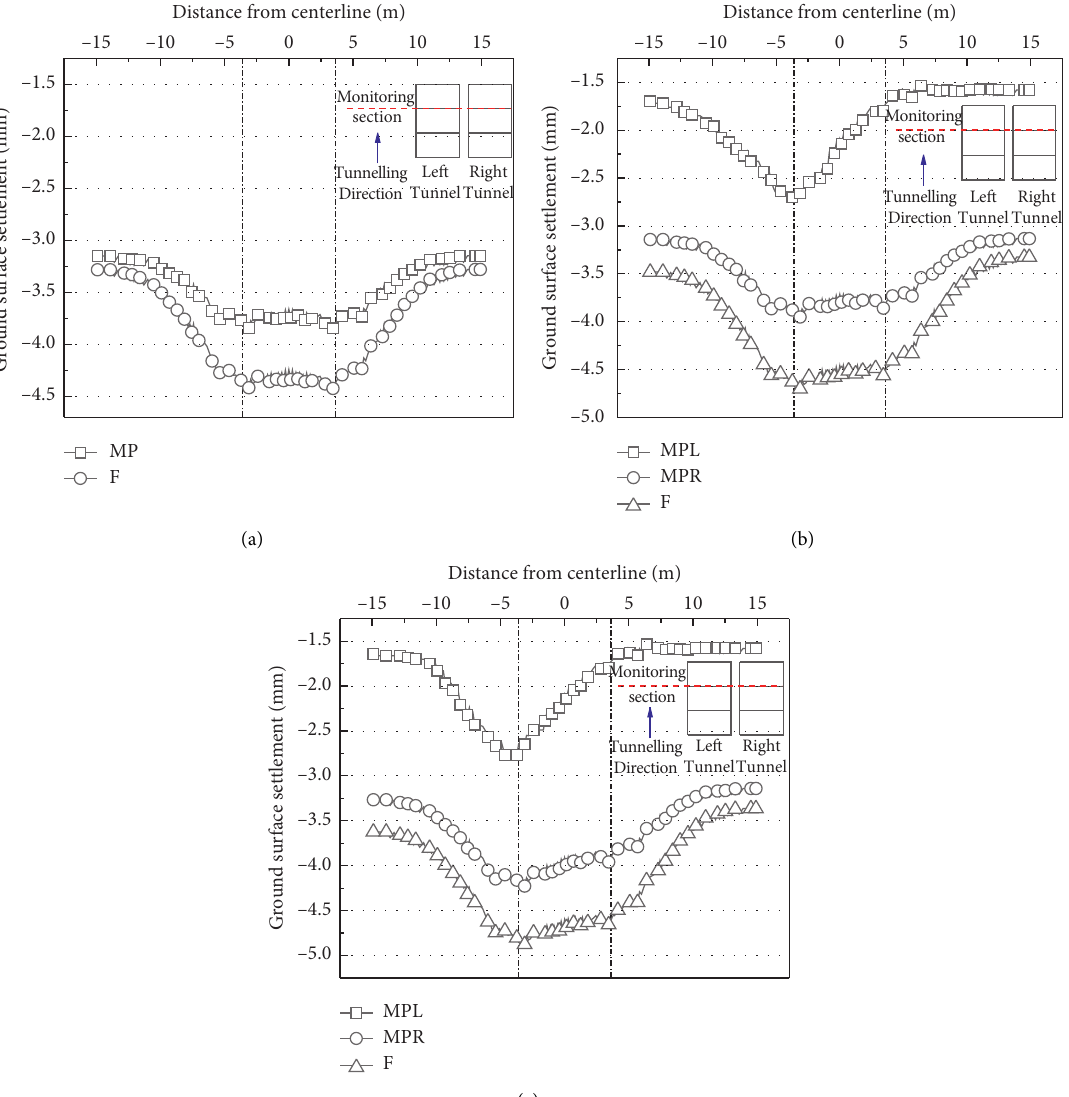
Figure 7: Surface settlement under different excavation conditions ( L